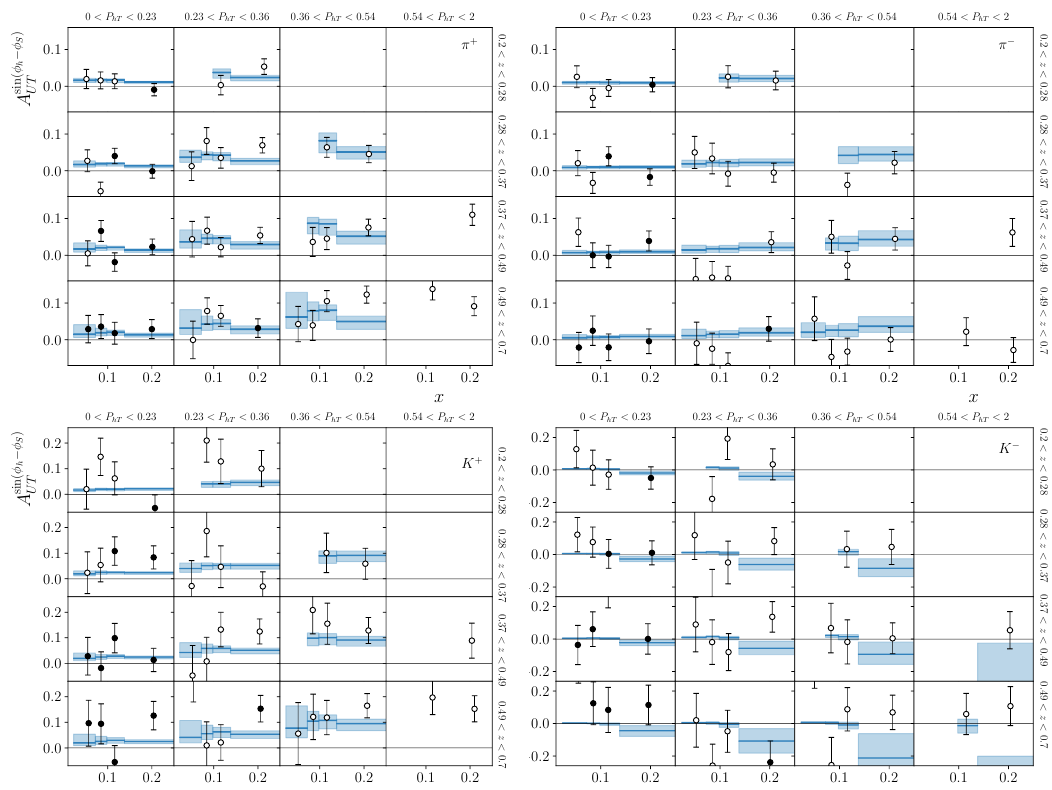
Figure 7. Description of HERMES data [35] for π ± and K ± , only data with δ < 0 . 5 are shown. The data are presented as the function of x and the 3D binning of the data is indicated by the bin sizes in P (GeV) and z . Solid (open) symbols data used (not used) in the fit. Blue line is the CF hT and the blue box is 68%CI of the fit of the data and prediction for the data not used in the fit.